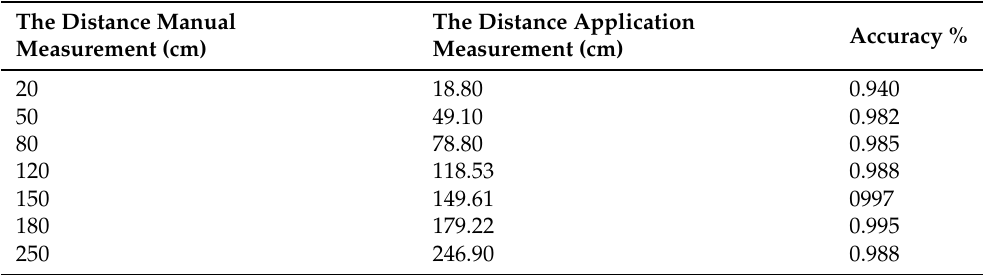
Table 4. The results showed the accuracy of the system compared to the manual measurement. The Distance Manual Measurement